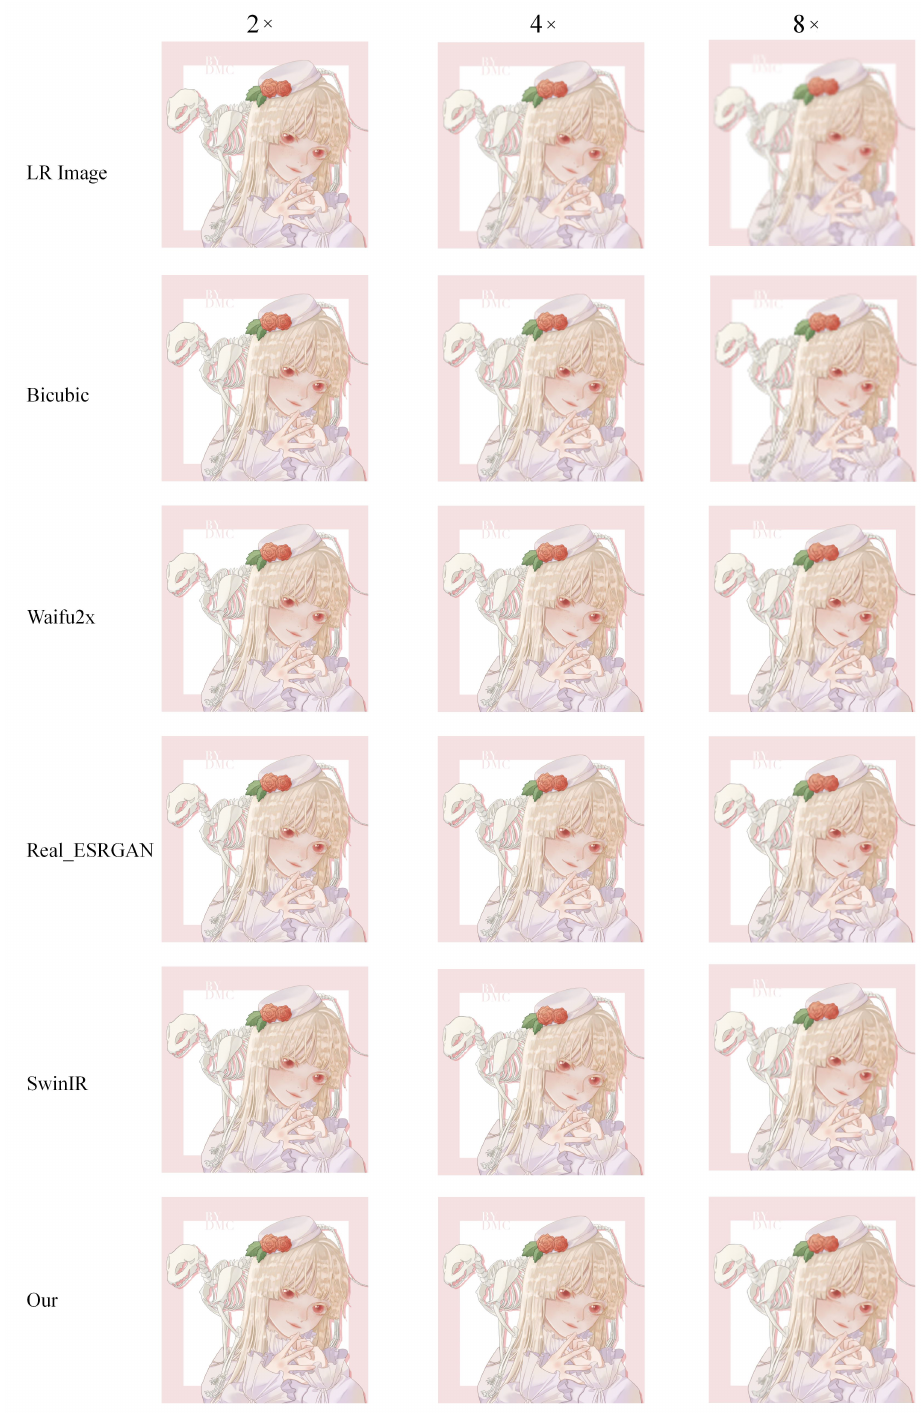
Figure 25. Result of an example image from the AnimeCharacter12 test dataset for different super- resolution methods at 2 × , 4 × , and 8 × super-resolution